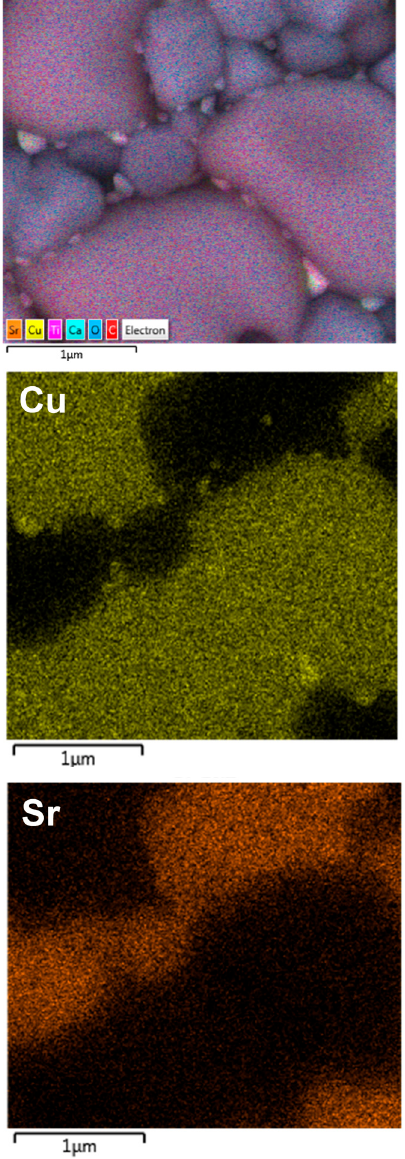
Figure 4. Backscattered field-emission SEM (FE-SEM) images with elemental mapping of Cu and Sr for the Sr30 composite sample.